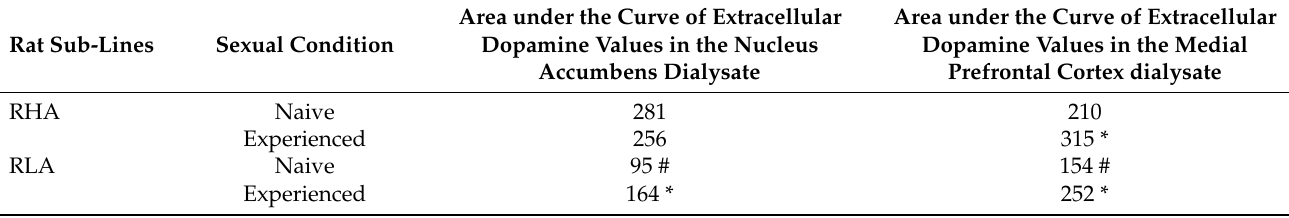
Table 13. Extracellular dopamine increases in the dialysate obtained from the nucleus accumbens and the medial prefrontal cortex of RHA and RLA rats during sexual activity at the first (sexually naïve condition) and at the fifth copulatory test (sexually experienced condition) with a receptive female